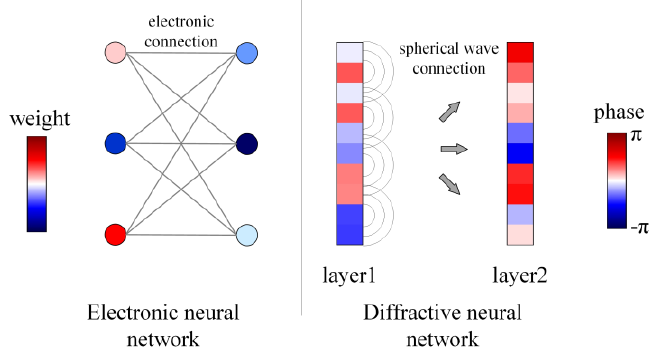
Figure 1. The comparation of two neural networks.